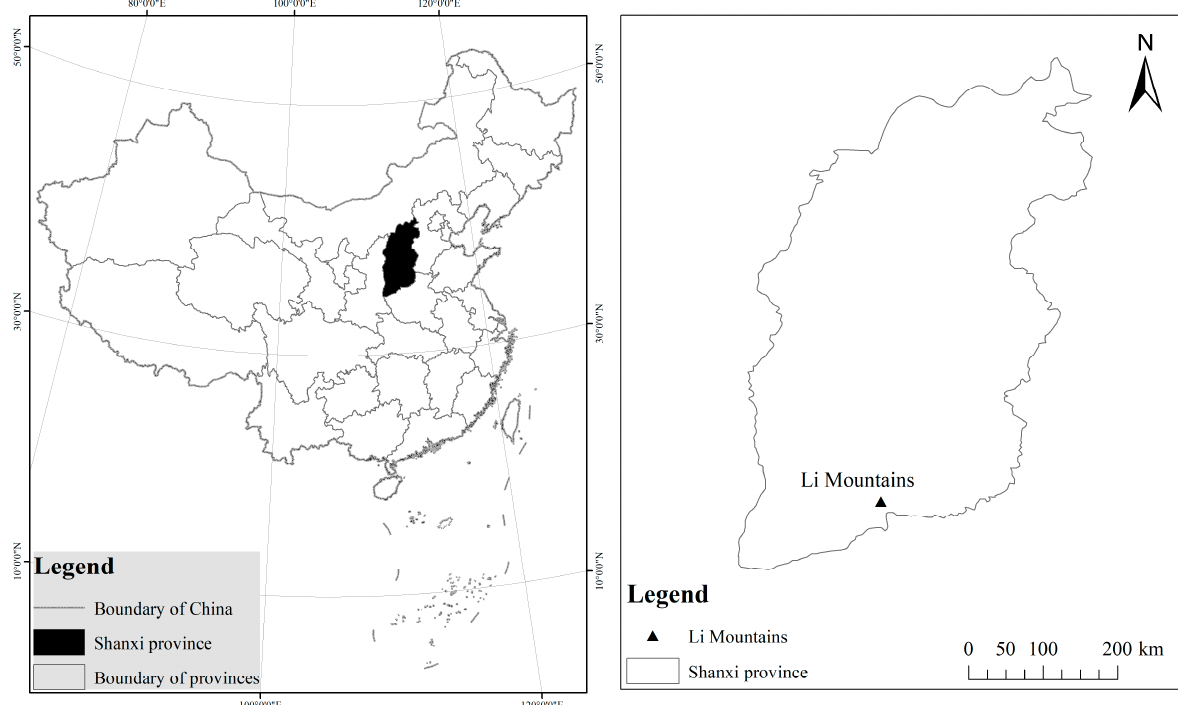
Figure 1. Location of the study area.